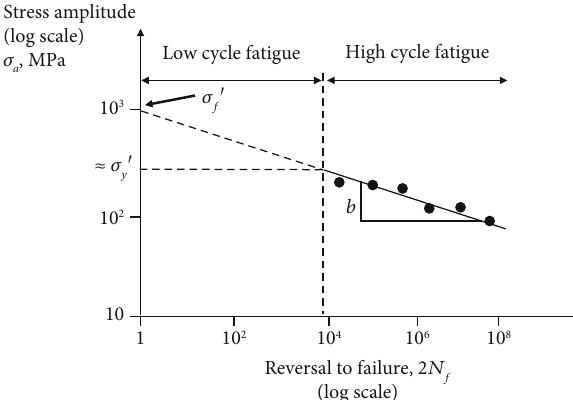
N a versus f curve [23].